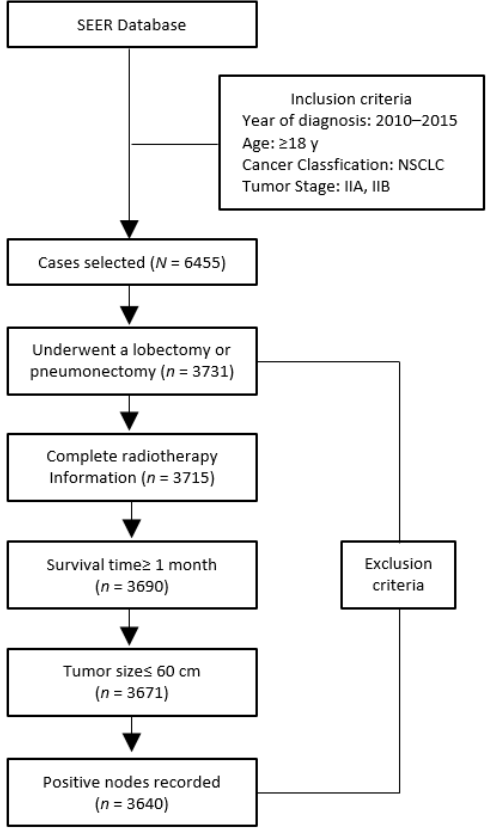
Figure 1. Flowchart of case inclusion and exclusion. NSCLC = non-small cell lung cancer. Variables involved in our study included the basic demographic information (age at diagnosis, sex, and race), tumor-related information (year of diagnosis, pathologic grade (I–IV or unknown)), tumor size, location (upper lobe, middle lobe, lower lobe, main bronchus, or others), histology (squamous cell carcinoma, adenocarcinoma, or others), stage (IIA or IIB), T stage (T1, T2, or T3), N stage (N0 or N1), number of positive lymph nodes, treatment information (surgery, RT, and CT), and survival information (survival time, vital status, cause-specific death, and other cause of death). Age at diagnosis,